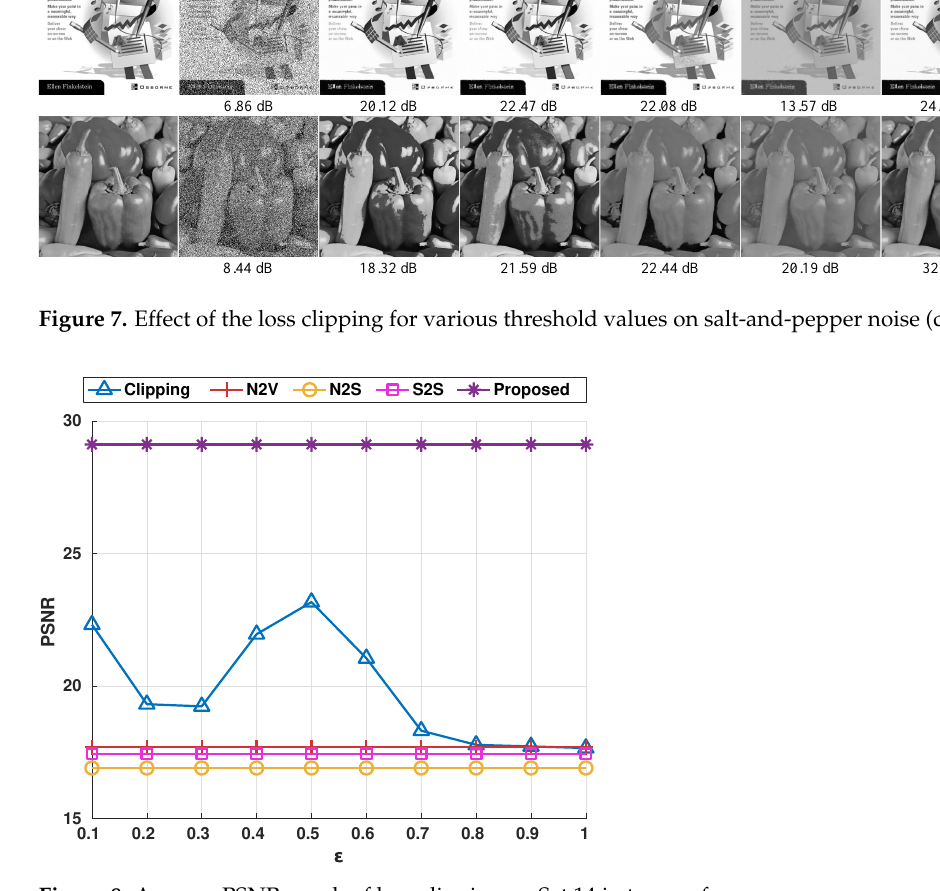
Figure 8. Average PSNR graph of loss clipping on Set 14 in terms of ε